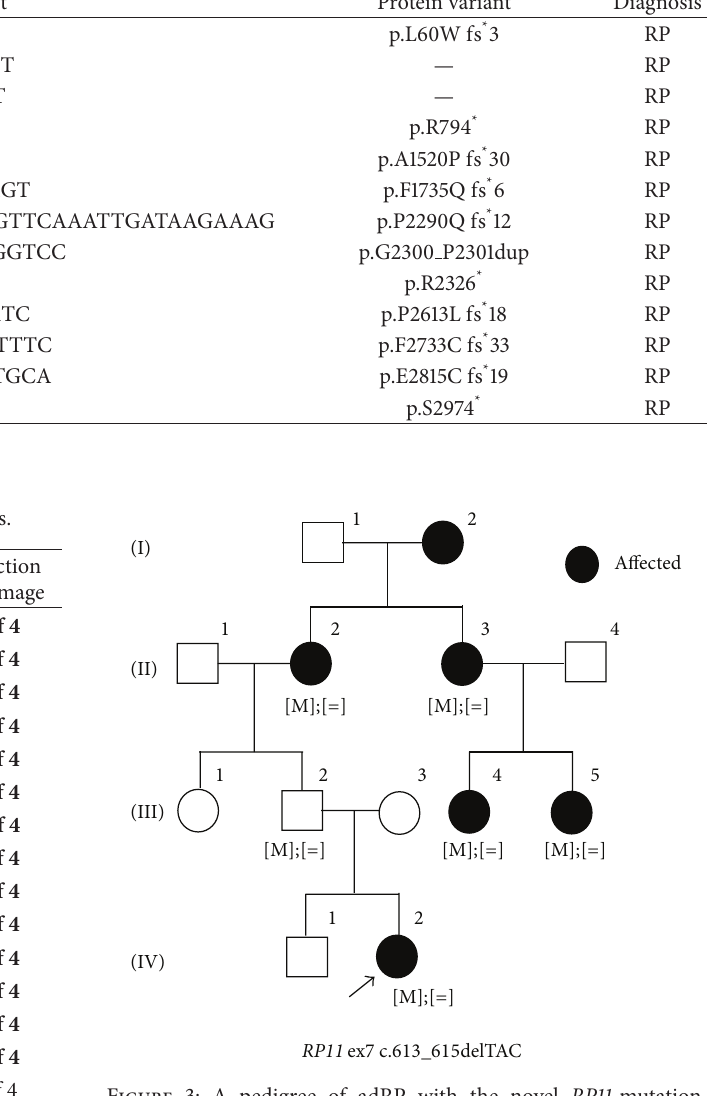
Figure 3: A pedigree of adRP with the novel RP11 mutation. A family carrying a novel c.613 615delTAC mutation in RP11 is presented. All of 6 family members who underwent molecular diagnosis carried the heterozygous c.613 615delTAC mutation as indicated with [M];[ = ]. Affected individuals are indicated as filled symbols, and an arrow indicates the proband in this family.